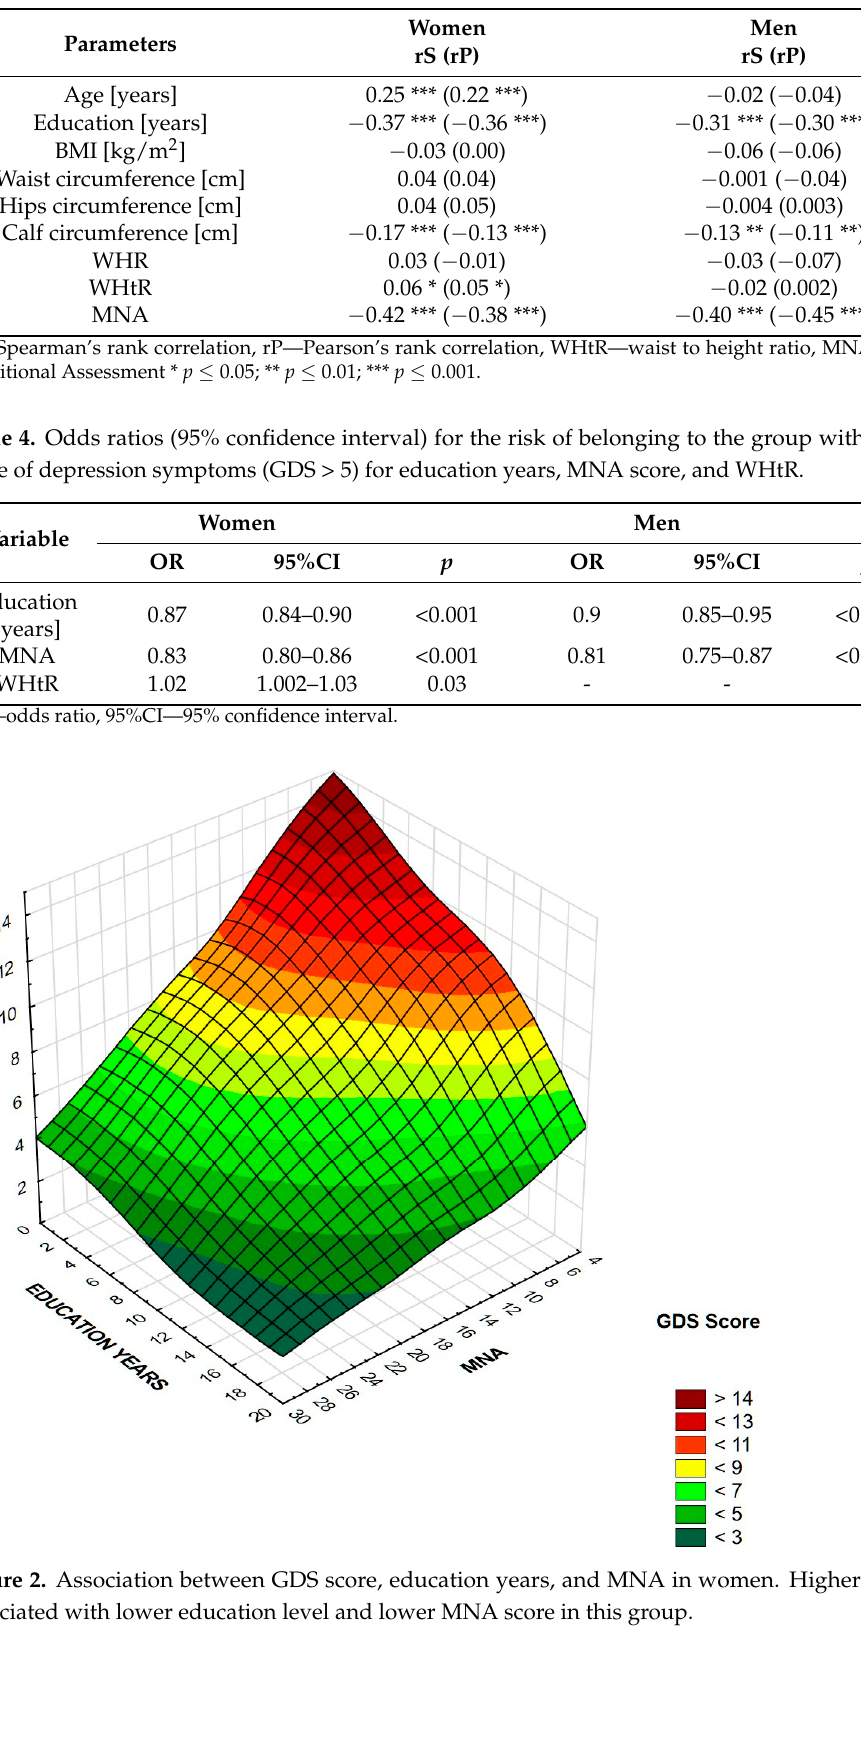
Figure 3. Association between GDS score, education years, and MNA in men. Higher GDS is asso- ciated with lower education level and lower MNA score in this group.